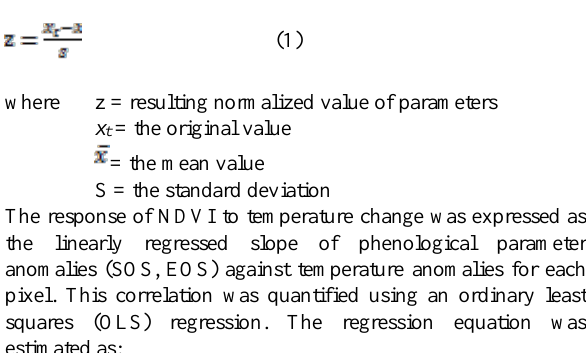
Table 1: Extracted phenology and climate parameters using midpoint technique